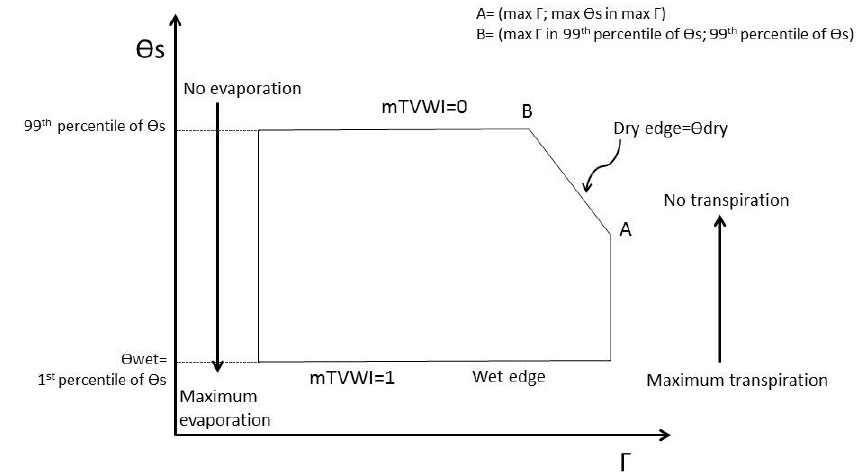
Figure 1. mTVWI scheme based on the relationship between potential surface temperature (θs) and the complementary values of crown defoliation